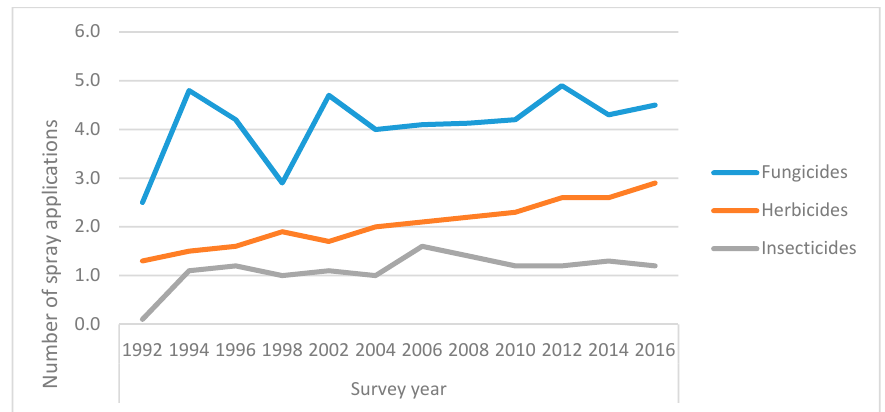
Figure 5. The application frequency of the major pesticide groups to arable crops in Northern Ireland 1992–2016.